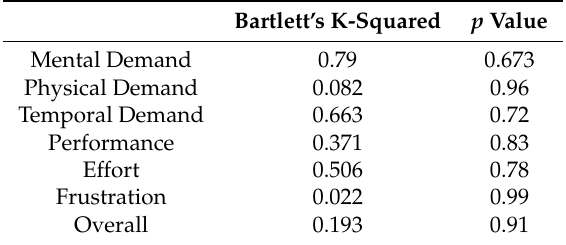
Table 1. Result of Bartlett’s test for